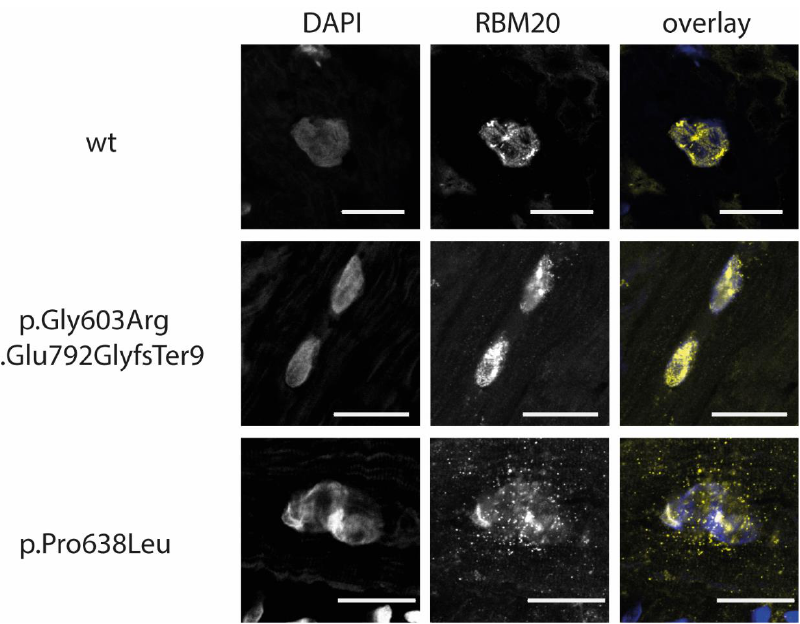
Figure 4. Immunohistochemical analysis of myocardial tissue of cardiomyopathy patients. Representative images of explanted myocardial tissue sections, which were labelled with primary anti RBM20 and Cy3-conjugated secondary antibodies (yellow in the overlay), are shown. Nuclei were labelled with DAPI (blue in the overlay). Tissue from a DCM patient with no RBM20 mutation was used as control. Comparable to the control sample RBM20 is localized in the nuclei in explanted myocardial tissue from IV.3. Sections from a DCM patient with the pathogenic RBM20 mutation p.Pro638Leu were used as a positive control for aberrant cytoplasmic RBM20 localization. Scale bars = 20 µm.